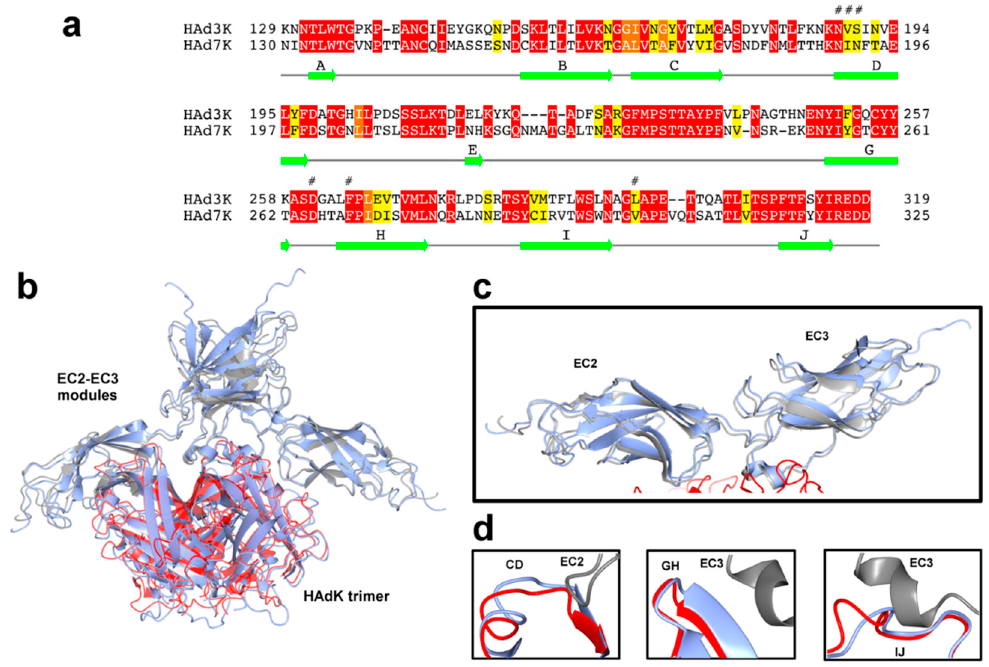
Figure 5. ( a ) Pairwise Sequence Alignment is used to identify regions of similarity between HAdV7 and HAdV3 fiber. For each pair of sequences the best global alignment is found using BLOSUM62 as the scoring matrix. A conservation index between 0 and 11 is calculated for each amino acid position on the alignment. Amino acids with a score above 9 are colored from red → orange → yellow corresponding to sequence conservation from high to low. ( b ) Superposition of HAd7K-(EC23) 2 and HAd3K-(EC23) 2 : EC2-EC3 modules interacting with HAd7K (in red) are colored in grey. HAd3K-(EC23) 2 complex is colored in blue. ( c , d ) Close-up views of superposed EC2-EC3 modules and superposed CD, GH, and IJ loops of HAdK, are shown individually.